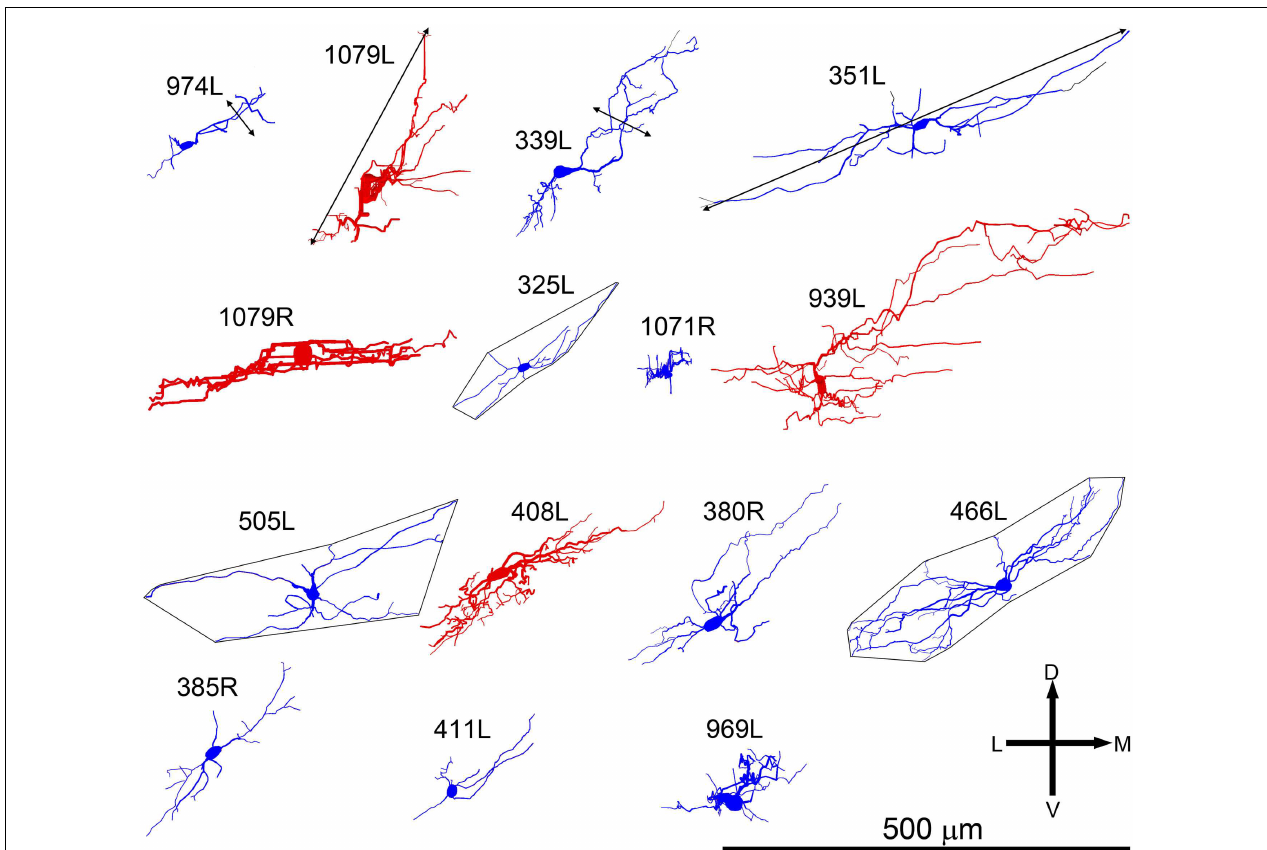
of their dendritic tree in or close to the coronal plane as illustrated by the double-headed black arrow for cells 974L and 339L.Their size was taken as the maximum dendritic extent measured in either the coronal or horizontal planes as illustrated by the double-headed arrow for cells 1079L and 351L. The area of the dendritic tree was measured in either the coronal or horizontal plane) by drawing a polygon round the main dendrites as illustrated for cells 325L, 505L, and 466L.They range in size from small, < 20,000 µ m 2 to large, > 45,000 µ m 2 with just under half (7/15) classed as